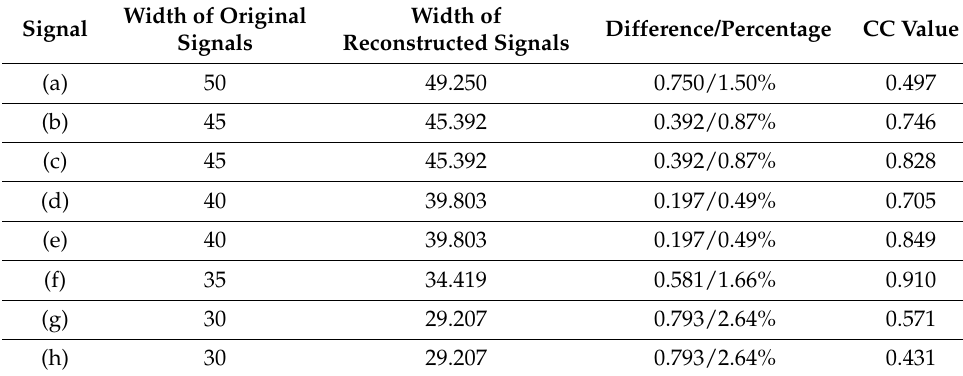
Table 5. Maximum widths a of the eight separated fringe patterns from Figure